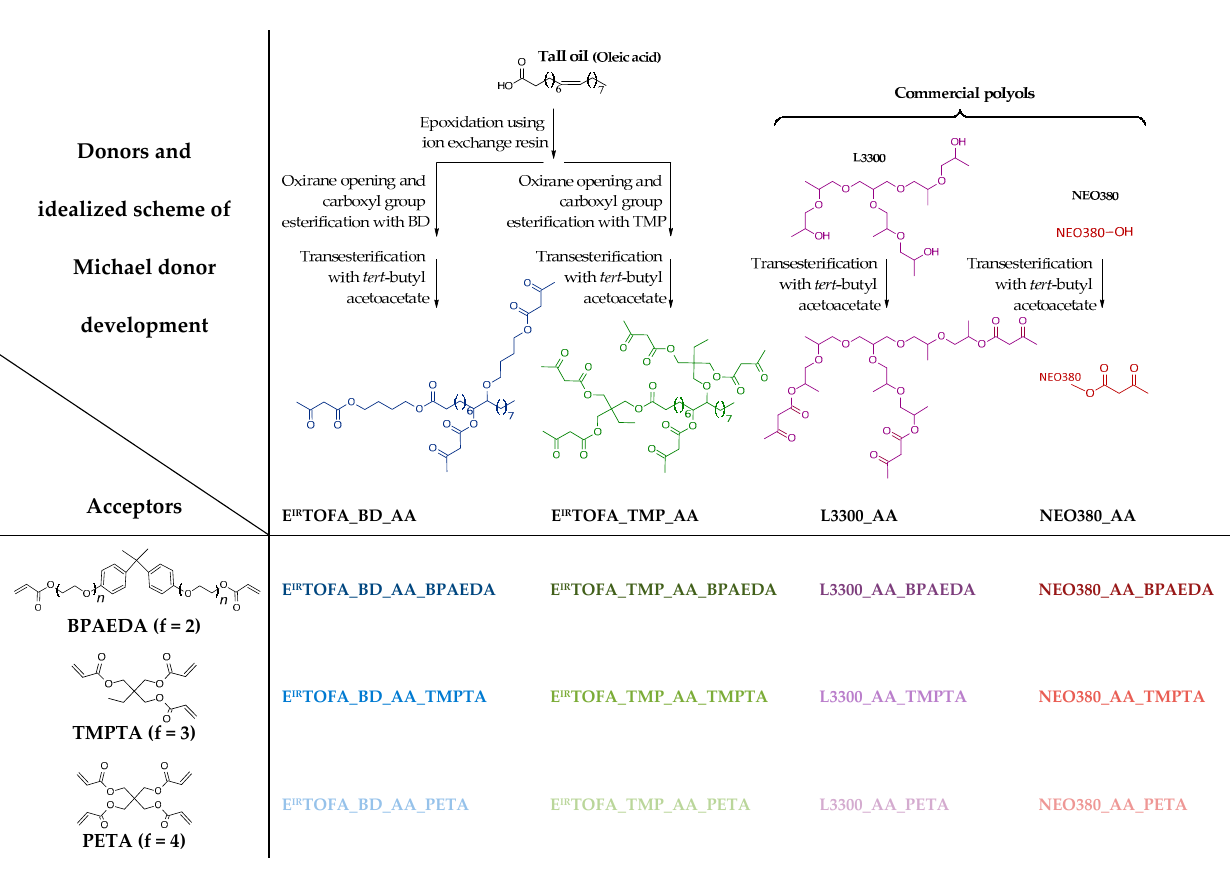
Figure 2. A schematic overview of polymer syntheses and synthesis of Michael donor